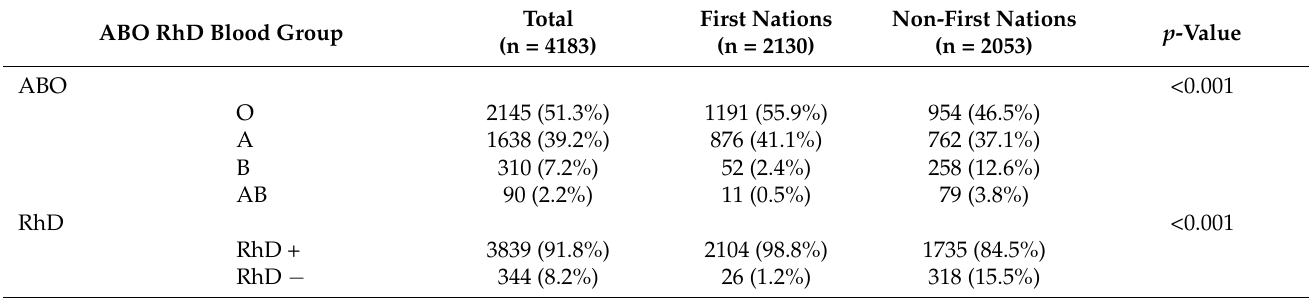
Table 3. ABO and RhD blood groups in First Nations versus non-First Nations